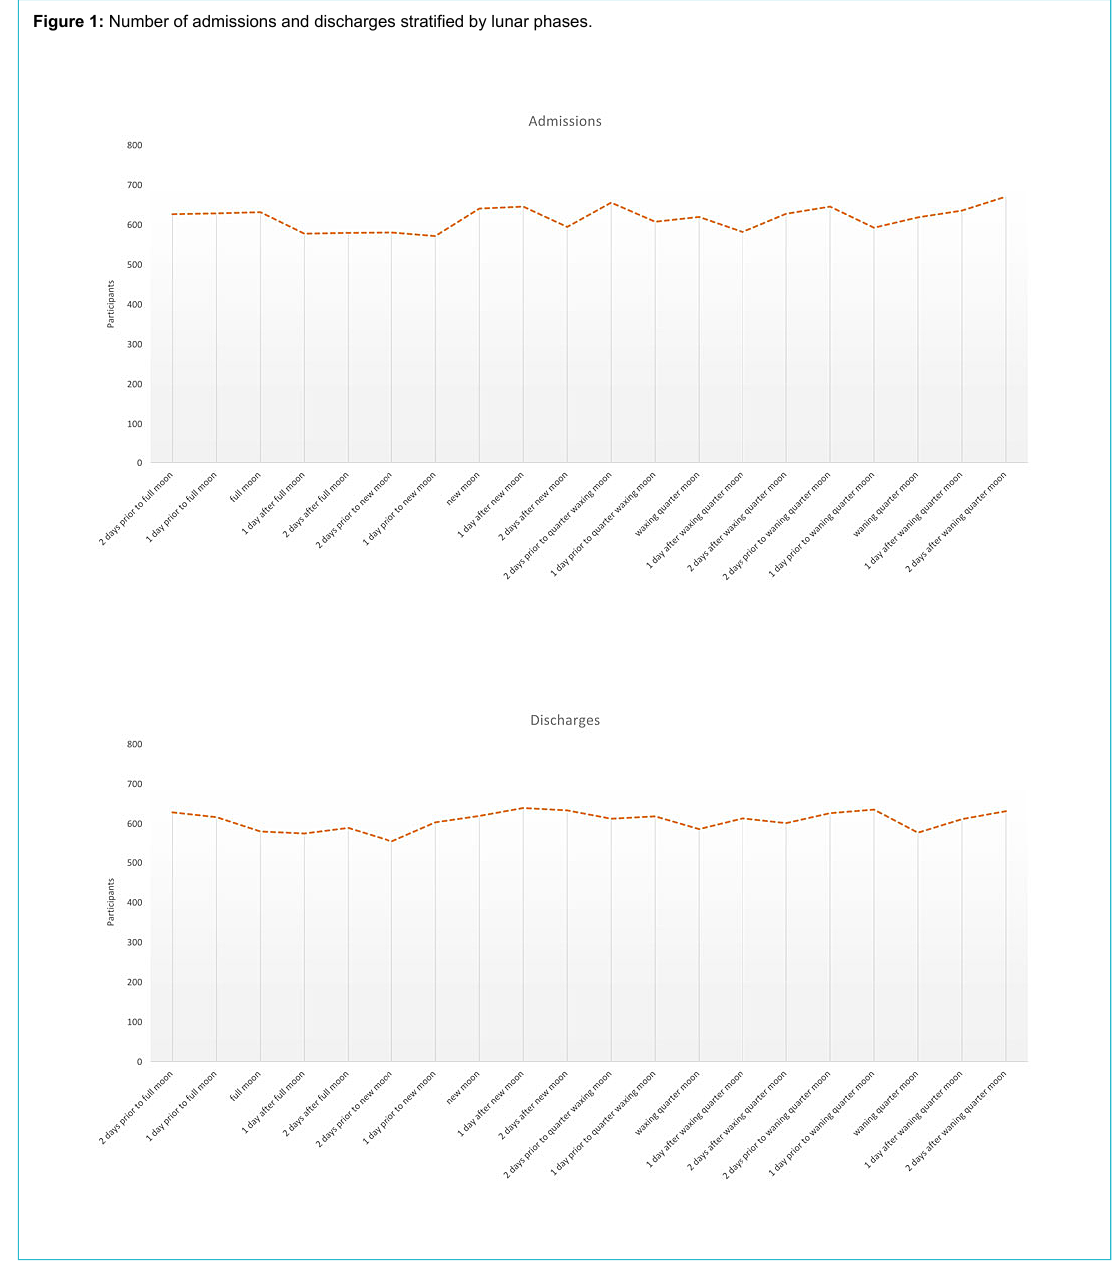
Figure 1: Number of admissions and discharges stratified by lunar